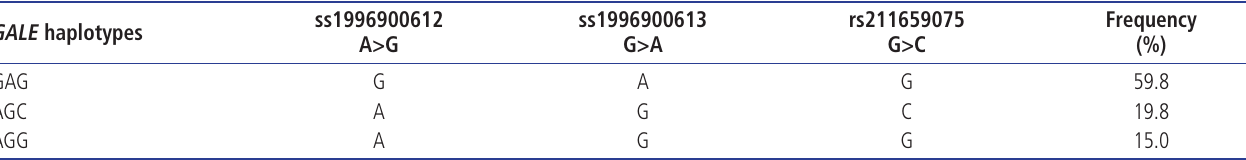
Table 5. Main haplotypes and their frequencies observed in GALE gene GALE haplotypes